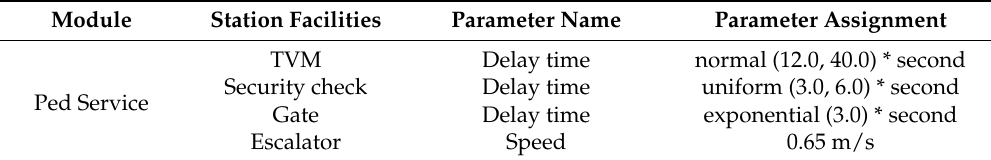
Figure 7. The inbound pedestrian behavior model. Table 4. Service parameters of the station facilities.